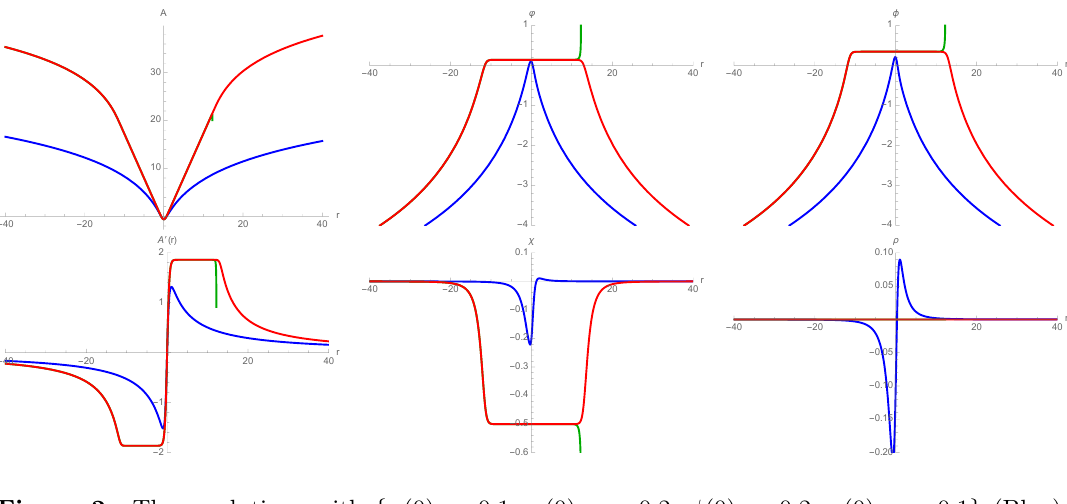
Figure 2 . Three solutions with f ’ (0) = 0 : 1, (cid:31) (0) = (cid:0) 0 : 2, (cid:30) (0) = 0 : 2, (cid:26) (0) = (cid:0) 0 : 1 g (Blue), f ’ (0) = ’ (cid:3) + 2 : 9 (cid:2) 10 (cid:0) 16 , (cid:31) (0) = (cid:31) (cid:3) , (cid:30) (0) = (cid:30) (cid:3) , (cid:26) (0) = (cid:26) (cid:3) g (Red), and f ’ (0) = ’ (cid:3) + 3 : 0 (cid:2) 10 (cid:0) 16 , (cid:31) (0) = (cid:31) (cid:3) , (cid:30) (0) = (cid:30) (cid:3) , (cid:26) (0) = (cid:26) (cid:3) g (Green). (cid:26) (0) = (cid:26) , by their critical point values, and we have only one initial condition to (cid:12)x, ’ (cid:3)